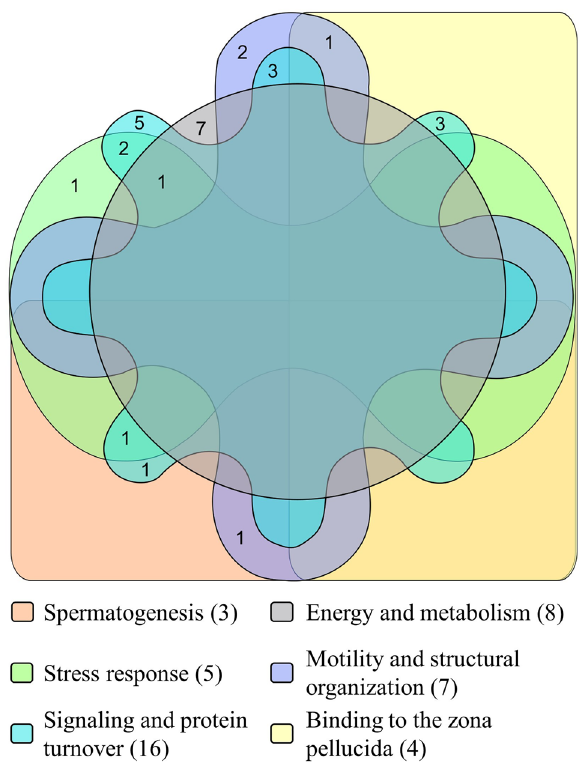
Figure 5. Venn diagram illustrating different functional groups for the proteins identified via HPLC-ESI-Q- TOF–MS/MS. The figure was created using the web-based tool InteractiVenn 88 .